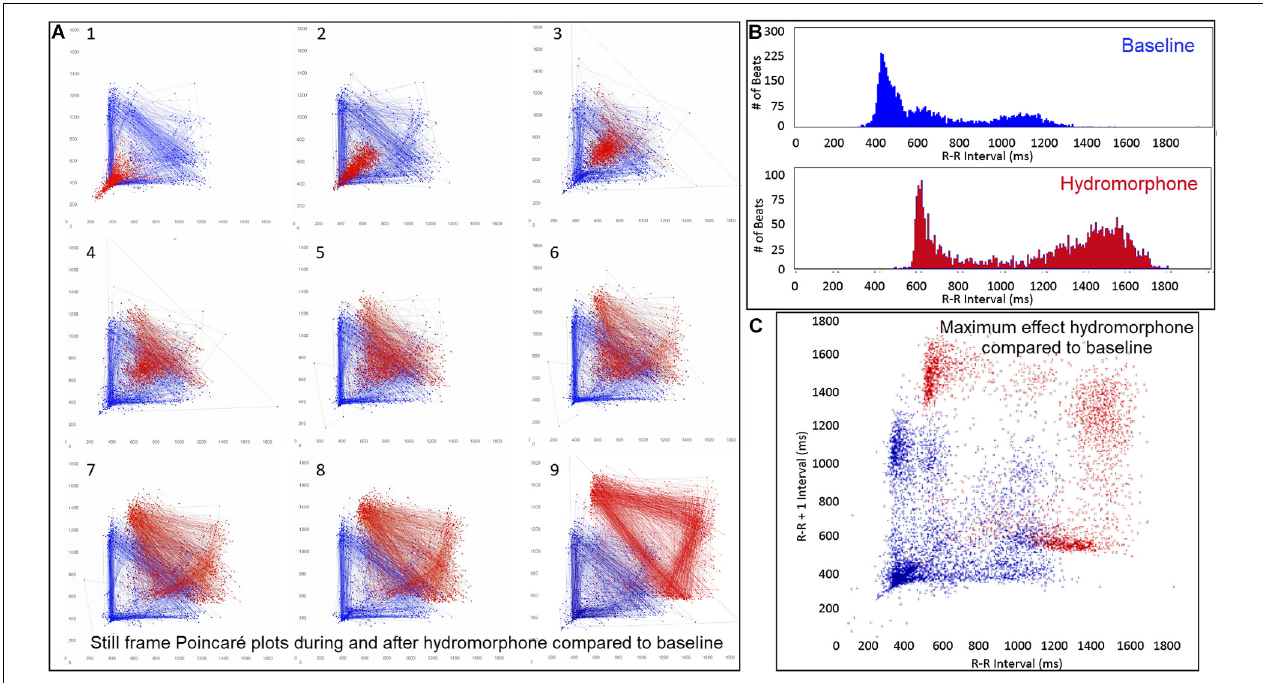
FIGURE 13 | ( Supplementary Video 9 ) Still frames from dynamic Poincaré plots (Frame A1–9 ) derived from intervals of 24-h electrocardiographic recordings from two different days during a stable rest period (blue) and just before and after administration of hydromorphone (red) (0.2 mg/kg given intravenously) given to beagle 1. Dots represent the beat-to-beat interval (R–R interval surrogate for P–P interval with all these verified to be sinus in origin) with lines connecting the next beat-to-beat interval. Each frame shows 1500 beat-to-beat intervals. After hydromorphone the beat-to-beat intervals become longer. In frames ( 1–5) the heart rate is faster because the dog is excited during the intravenous administration and then calms as the drug takes effect. The heart rate and beat-to-beat interval pattern changes with increasing drug effect. The characteristic pattern with a paucity of beat intervals (zone of avoidance) and beat intervals that do not hover around the line of identity are seen in the dog with high parasympathetic modulation induced by the hydromorphone. In frame (B) the number of beats at a particular beat interval are shown for the stable rest period (blue) and during treatment with hydromorphone (red). In frame (C) , the Poincaré plot illustrates a comparison without the connecting lines of the entire baseline period and the time of maximum effect of hydromorphone. Supplementary Video 9 complements this